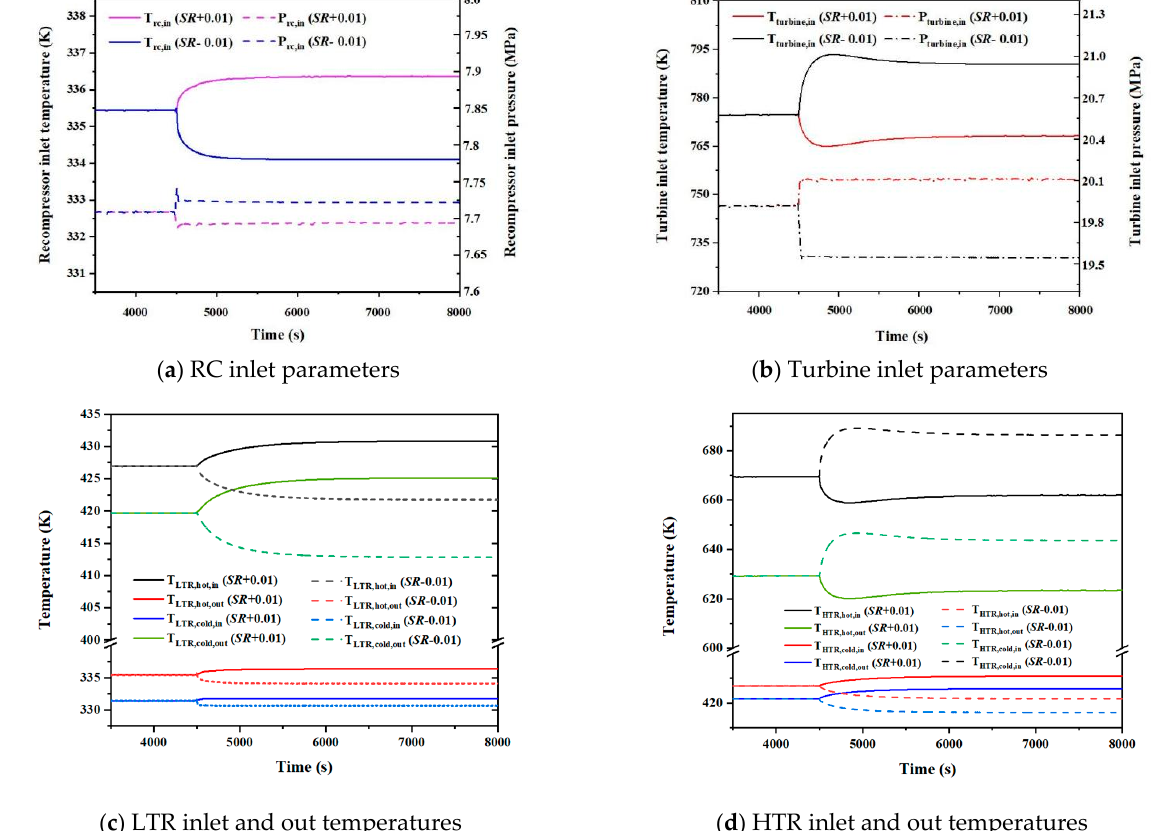
Figure 7. Response curves of main parameters with SR disturbance.